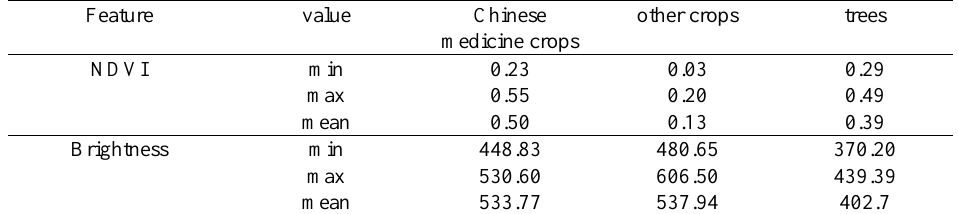
Table4. Sample texture feature values of different ground objects.